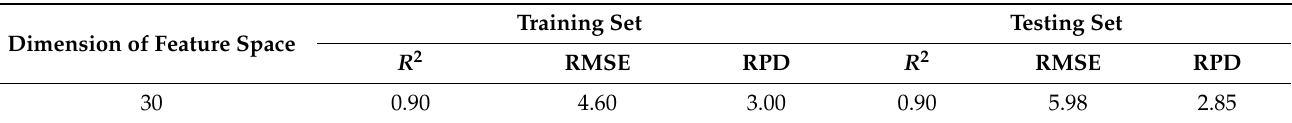
Table 7. The predictive performance of PLSR models built with GA-BP algorithm.